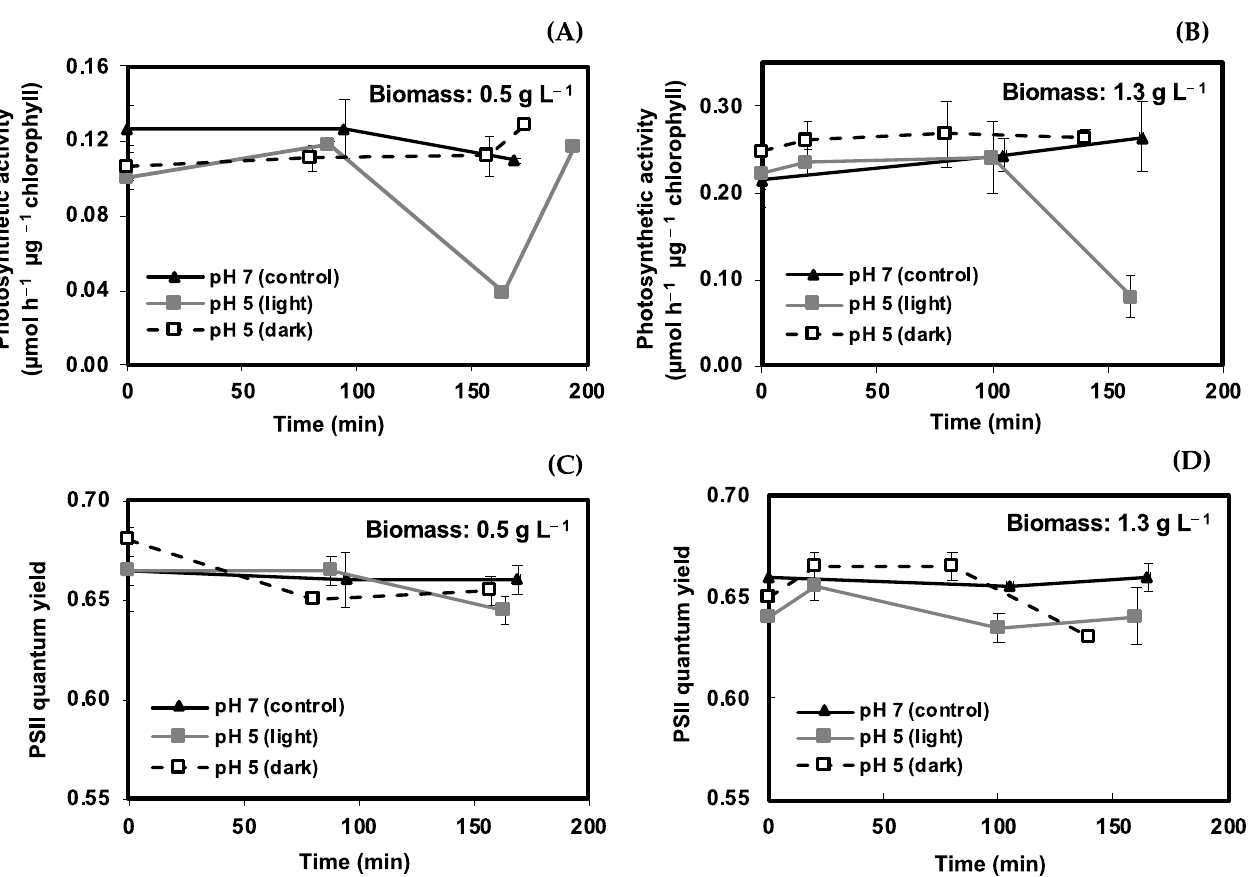
Figure 2. Effect of the pH change on the microalgae activity by HCl addition. ( A ) Photosynthetic activity when a biomass concentration of 0.5 g L − 1 was used. ( B ) Photosynthetic activity when a biomass concentration of 1.3 g L − 1 was used. ( C ) PSII quantum yield when a biomass concentration of 0.5 g L − 1 was used. ( D ) PSII quantum yield when a biomass concentration of 1.3 g L − 1 was used. To study the preferred inorganic carbon source of C. sorokiniana , the apparent affinity